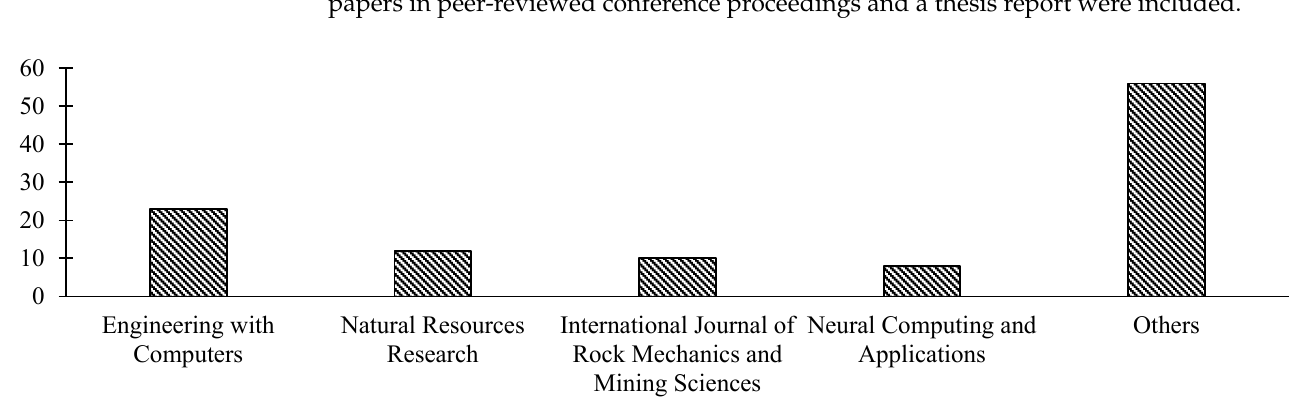
Figure 3. Journals with the most counts of publications in the machine learning application in the blast-induced impact predictions in this review.